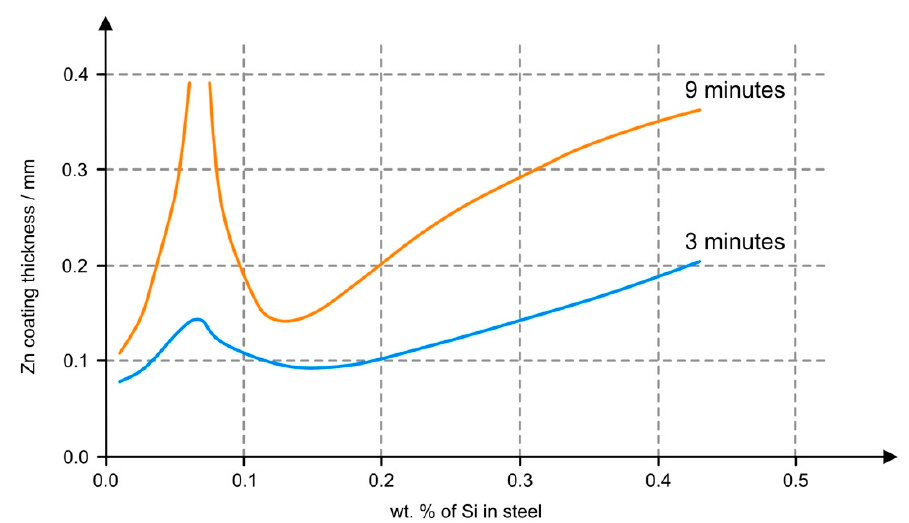
Figure 2. Relationship between the silicon content in the steel and the thickness of the zinc coating [35]. Table 6. The measured thickness of the zinc